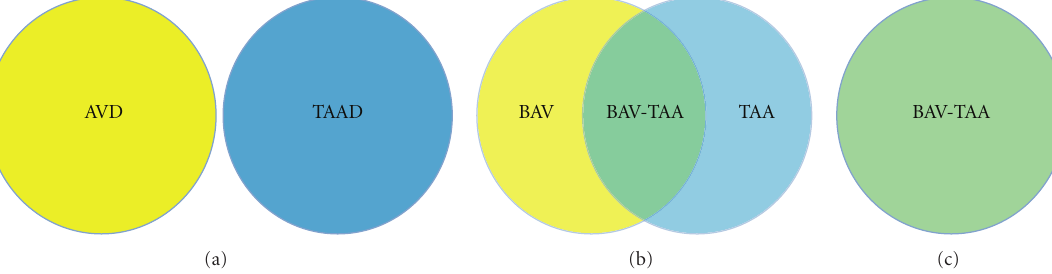
Figure 3: Potential relationships between BAV and TAA. From a disease standpoint, AVD and thoracic dissection (TAAD) represent distinct entities that a ff ect di ff erent tissue types (a). However, in light of the clinical association between the respective endophenotypes BAV and TAA, there are 3 patient populations, namely, those with BAV (with or without AVD), those with TAA, and those with BAV and TAA (b). From a genetic and developmental perspective, there is increasing evidence of etiologic overlap, suggesting a shared complex genotype